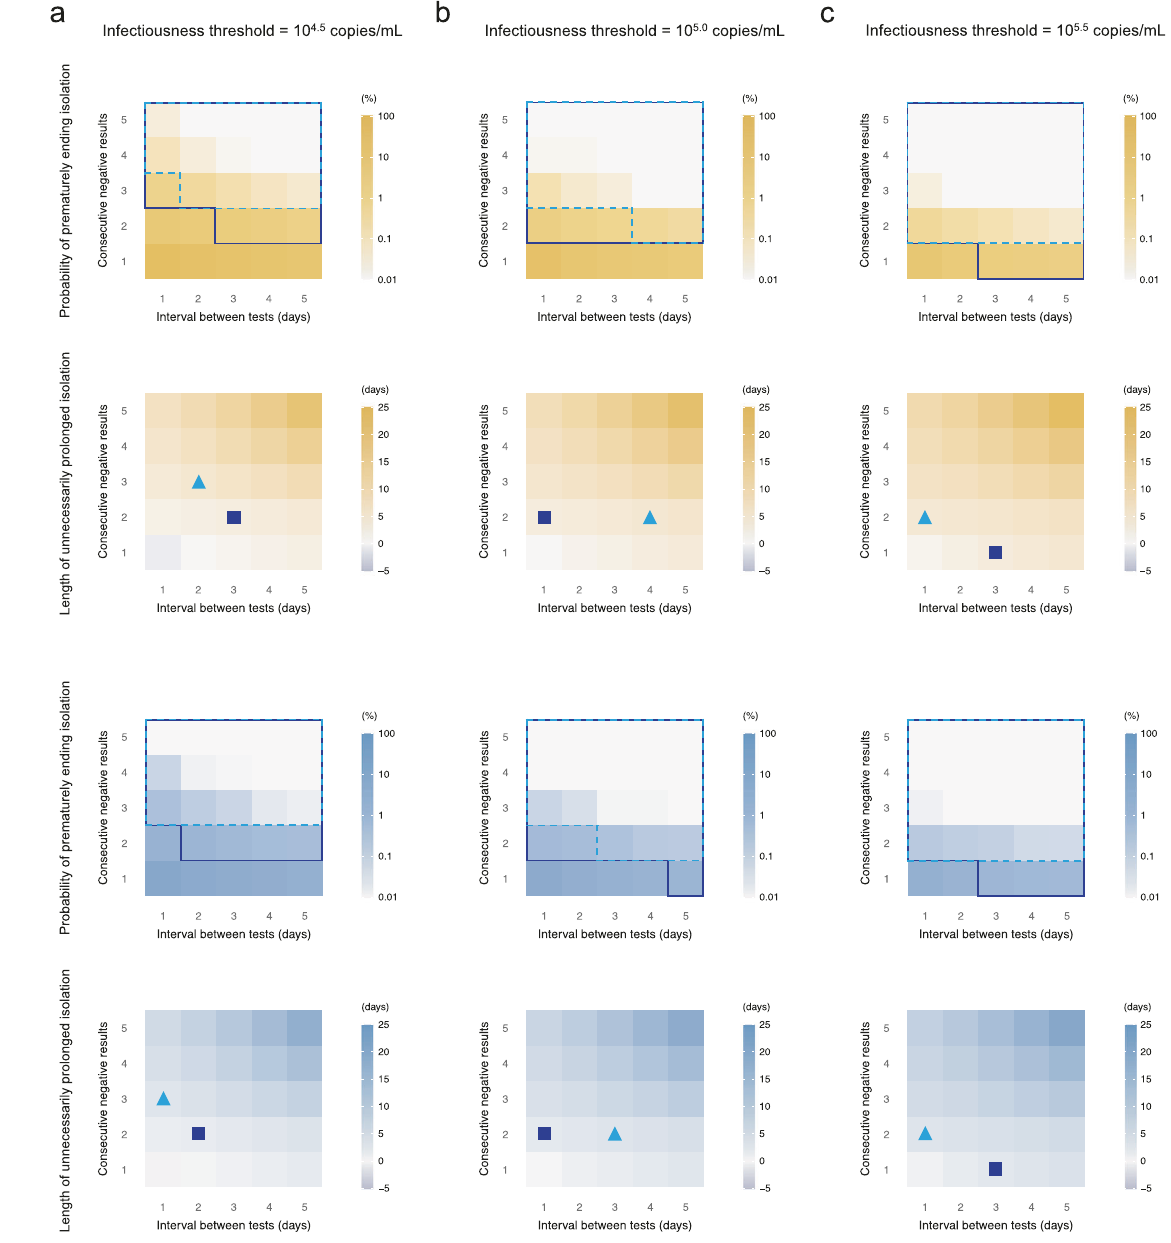
Fig. 2 | Optimal isolation guideline for symptomatic and asymptomatic cases using antigentest (detectionlimit=10 4 copies/mL). a Probability of prematurely ending isolation (upper panels) and mean length of unnecessarily prolonged iso- lation (lower panels) for different values of the interval between antigen tests and thenumberofconsecutivenegativeresultsnecessarytoendisolationforeachcase; the infectiousness threshold value is set to 10 4.5 copies/mL. The areas surrounded bysky-blue dotted linesand bluesolid linesarethose with1%or5% orlowerof risk of prematurely ending isolation of infectious patients, respectively, and the